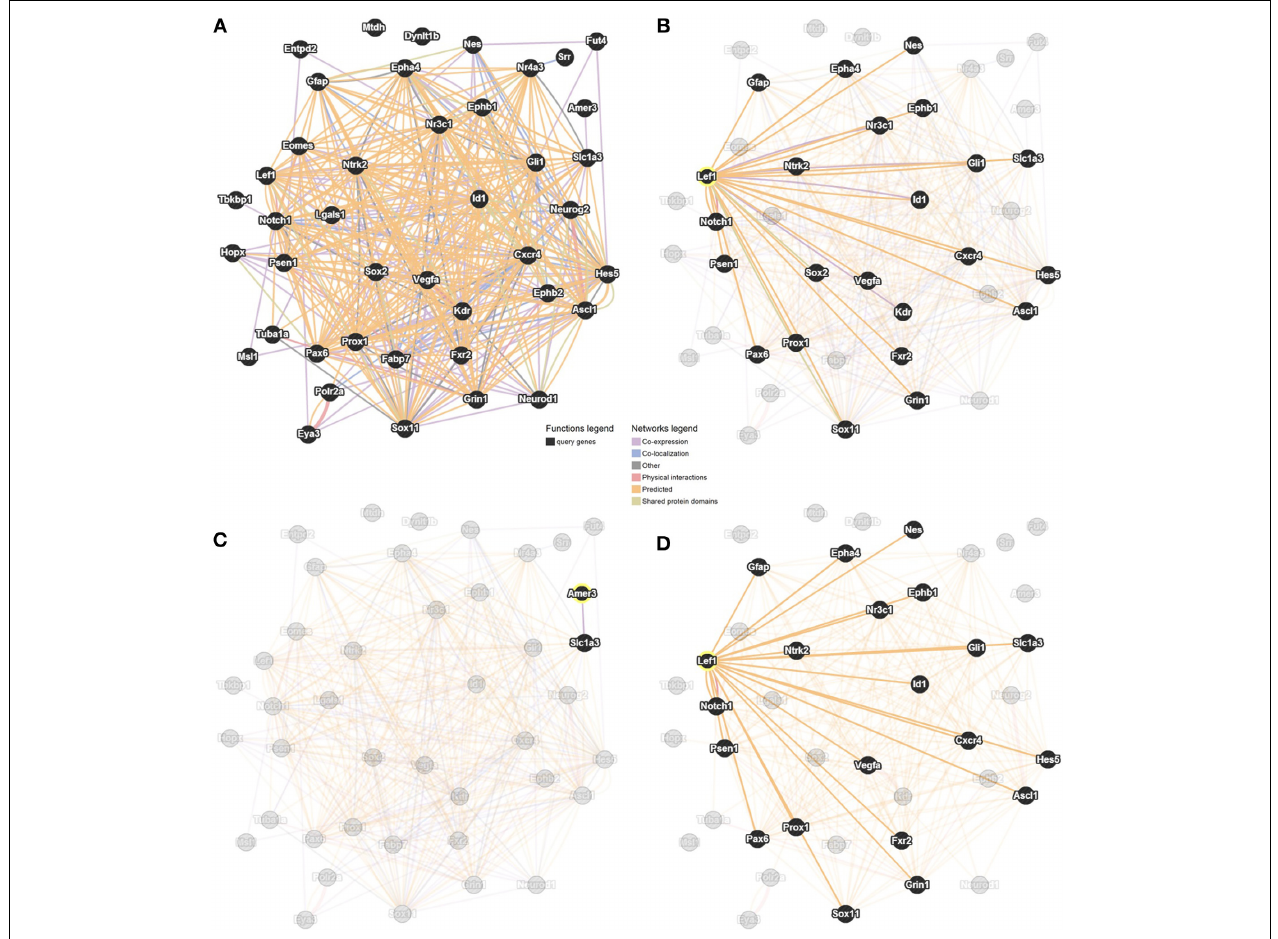
FIGURE 4 | Interaction network between the six candidate genes, Lef1 and 35 MANGO genes expressed in Nestin-positive cells. Adapted from GeneMANIA (http://genemania . org; Mostafavi et al., 2008; Warde-Farley et al., 2010) with links based on co-expression, co-localization, physical and genetic interactions, as well as shared